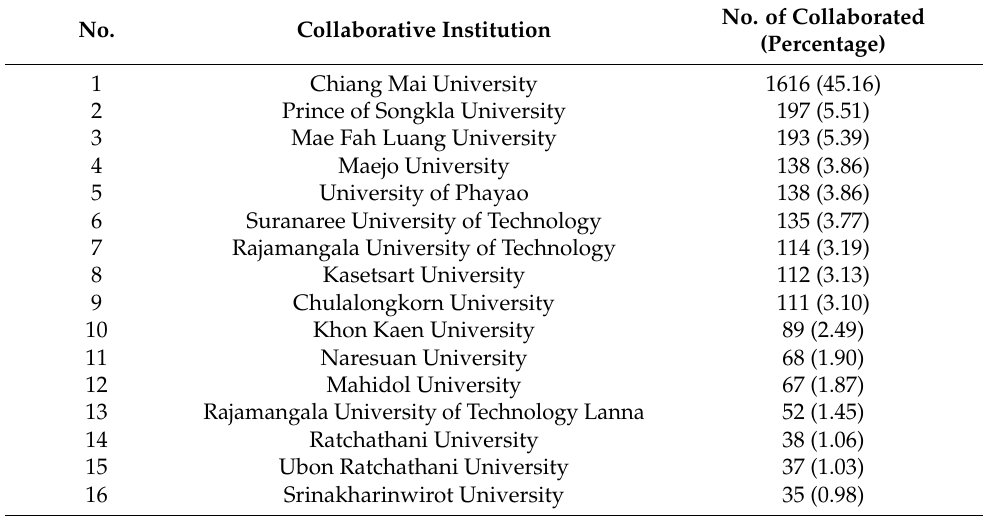
Table 4. Top 16 Most Collaborative Institutions.